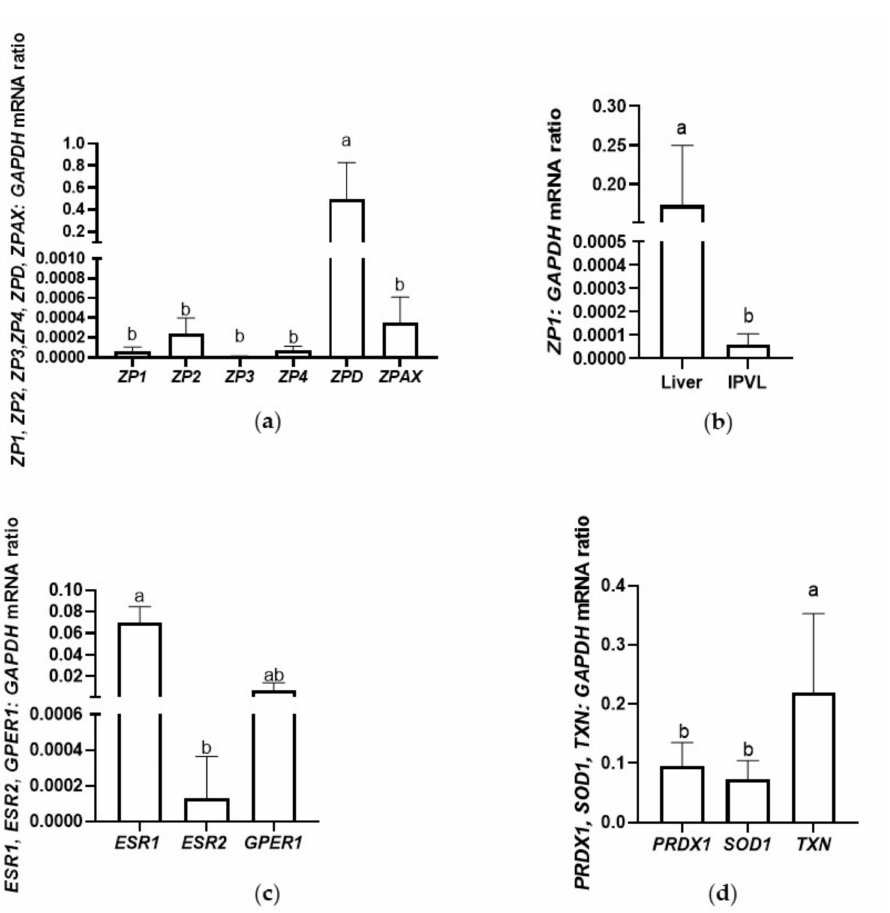
Figure 3. Real-time validation of selected genes identified in the inner perivitelline layer by RNA-Seq. Validation was performed using the same RNA samples as for NGS. Data are expressed as mean ± SD. ( a ) Expression of six zona pellucida glycoprotein genes (ZP1, ZP2, ZP3, ZP4, ZPD, and ZPAX); ( b ) Expression of ZP1 in the liver and the IPVL; ( c ) Expression of three genes involved in estrogen receptor signaling (ESR1, ESR2, and GPER1); and ( d ) Expression of three genes involved in the NRF2- mediated oxidative stress response (SOD1, PRDX1, and TXN). GAPDH: glyceraldehyde-3-phosphate dehydrogenase. Different letters indicate statistical significance at P ≤